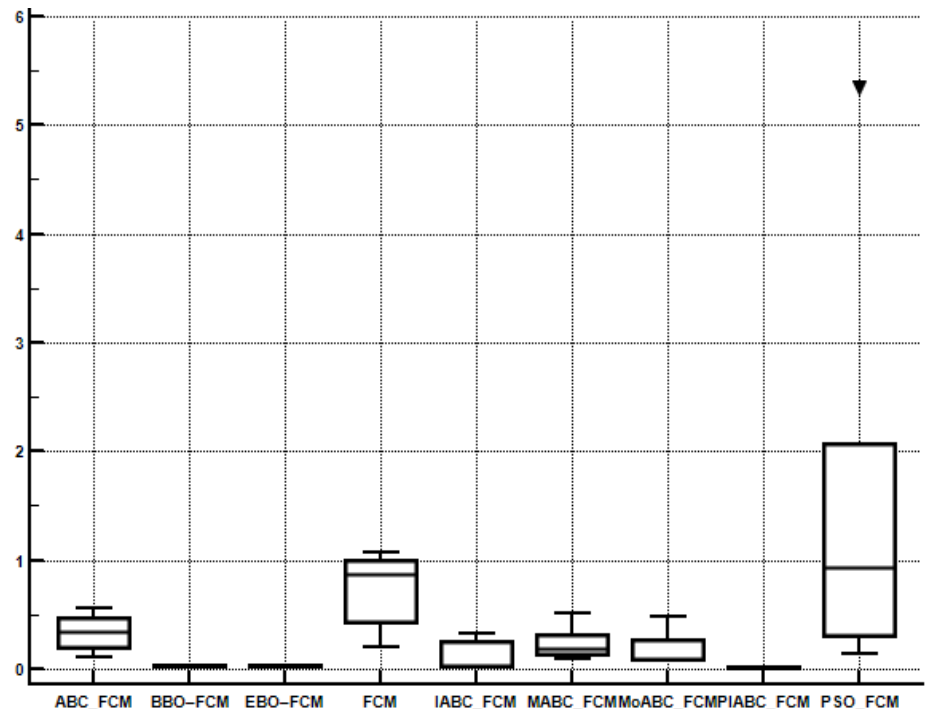
Figure 6. Box-whisker graph to present the outcomes of CE index.